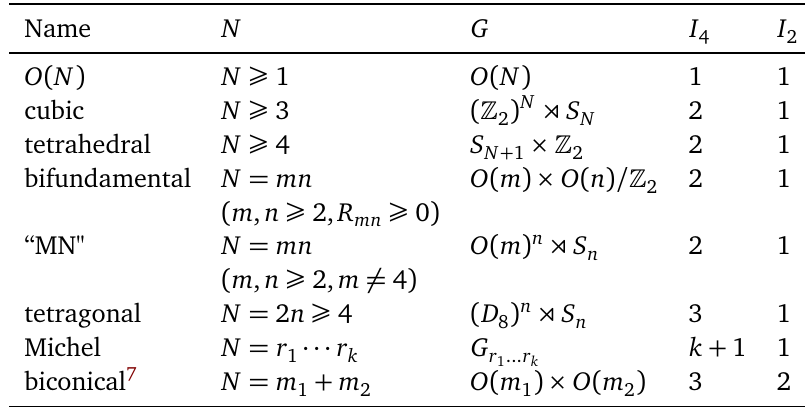
Table 1: Summary of examples of fully interacting fixed points given in